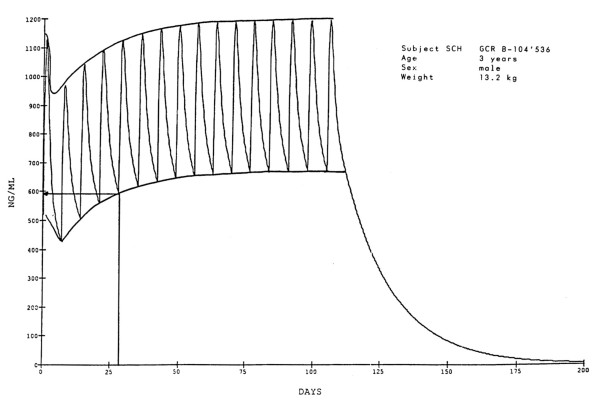
Plasma levels during chemoprophylaxis in children. The Figure shows the simulated plasma levels of mefloquine expected to be achieved in a child weighting 13 kg who received an initial dose of 125 mg of mefloquine and then 16 weekly prophylaxis doses of 62.5 mg mefloquine (equivalent to the currently recommended ¼ tablet for this weight category of child). Mefloquine concentrations of 620 ng/mL (= 1.67 μmol/L) are considered to be effective against Plasmodium falciparum in the bloodstream.